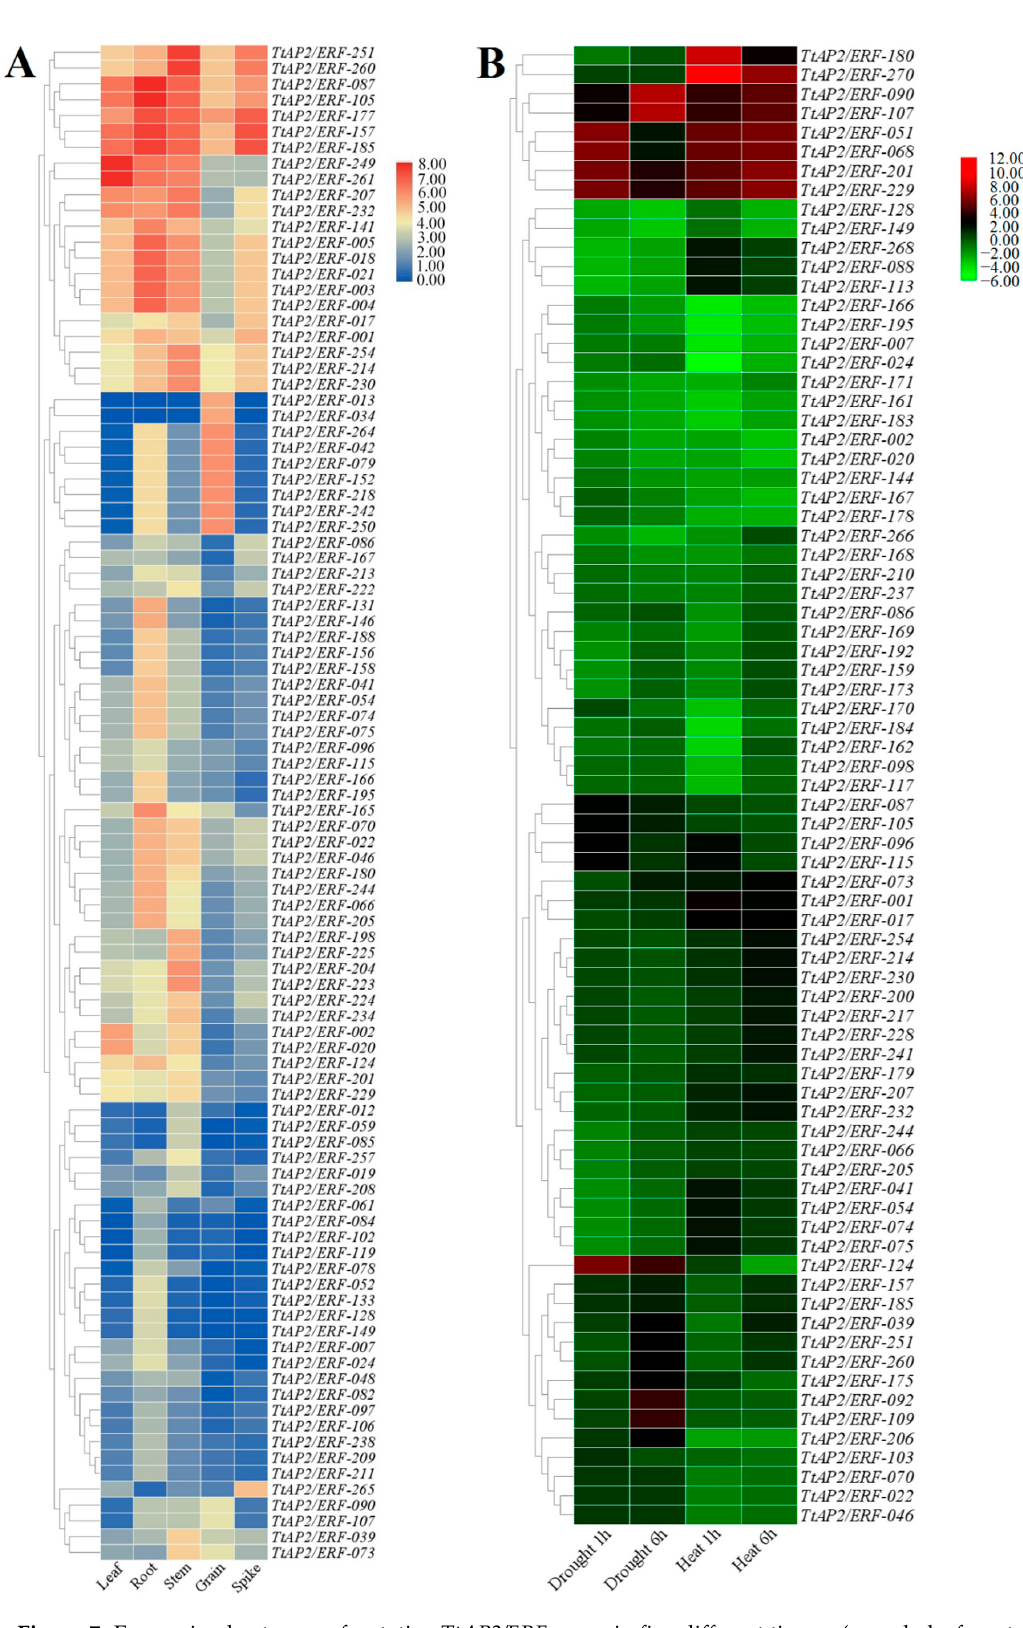
Figure 7. Expression heatmaps of putative TtAP2/ERF genes in five different tissues (namely leaf, root, stem, grain, and spike) of durum wheat ( A ) and under drought (1 and 6 h) and heat stresses (1 and 6 h) conditions ( B ).